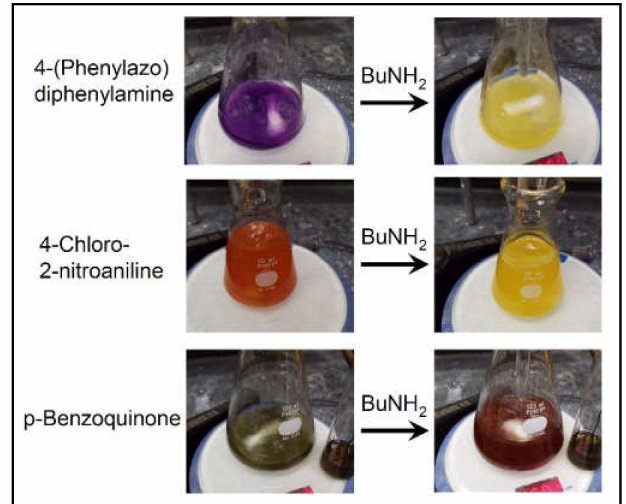
various Hammet indicators, each sensitive to a different pKa.